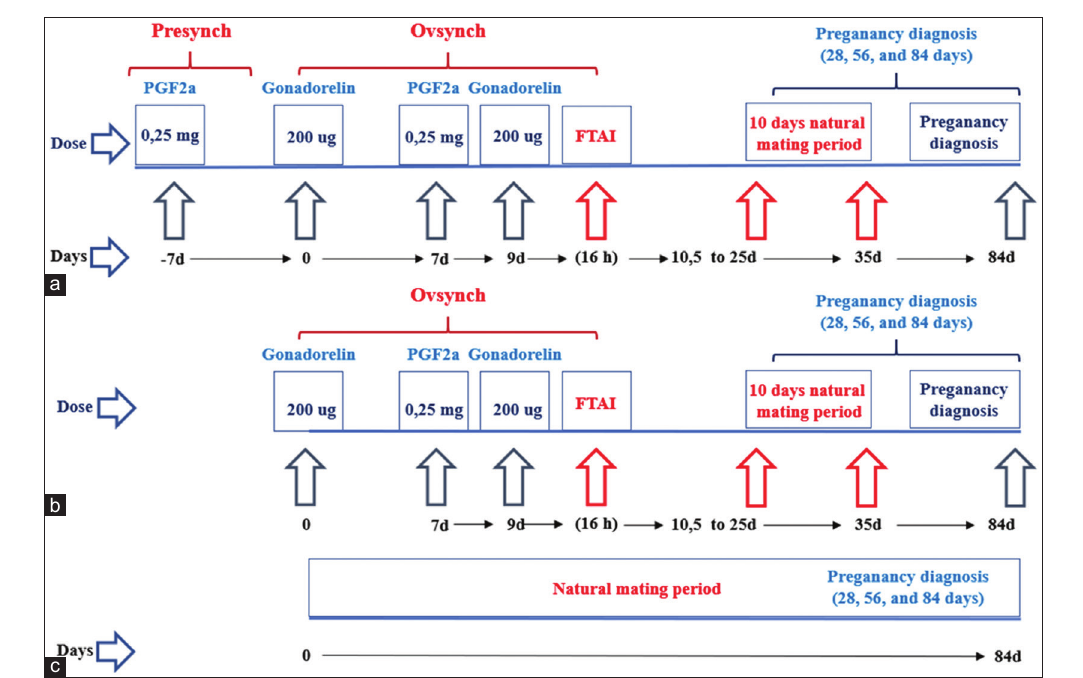
Figure-1: Experimental schedule of the study. a: Pre-synch+Ovsynch protocol. b: Ovsynch protocol. c: Control